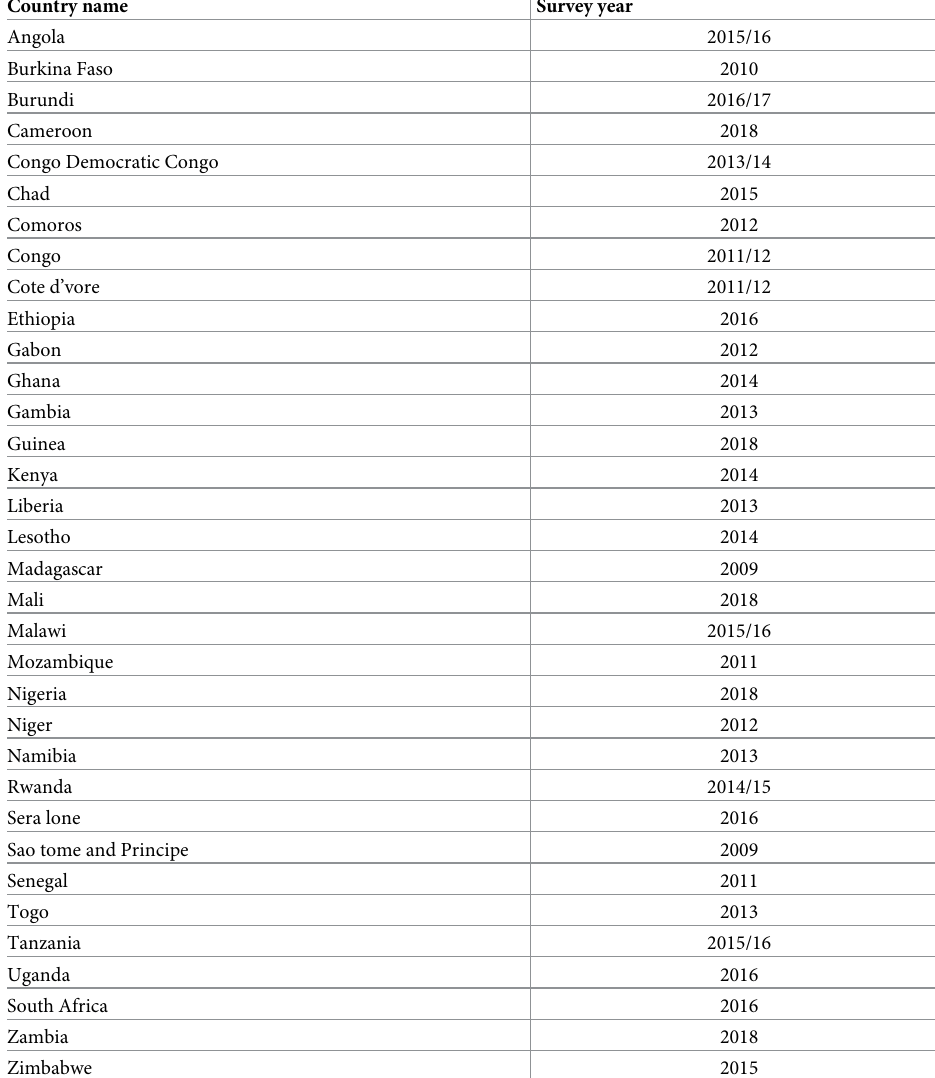
Table 1. List of sub-Saharan countries and their demographic and health survey’s year included in the analysis. Country